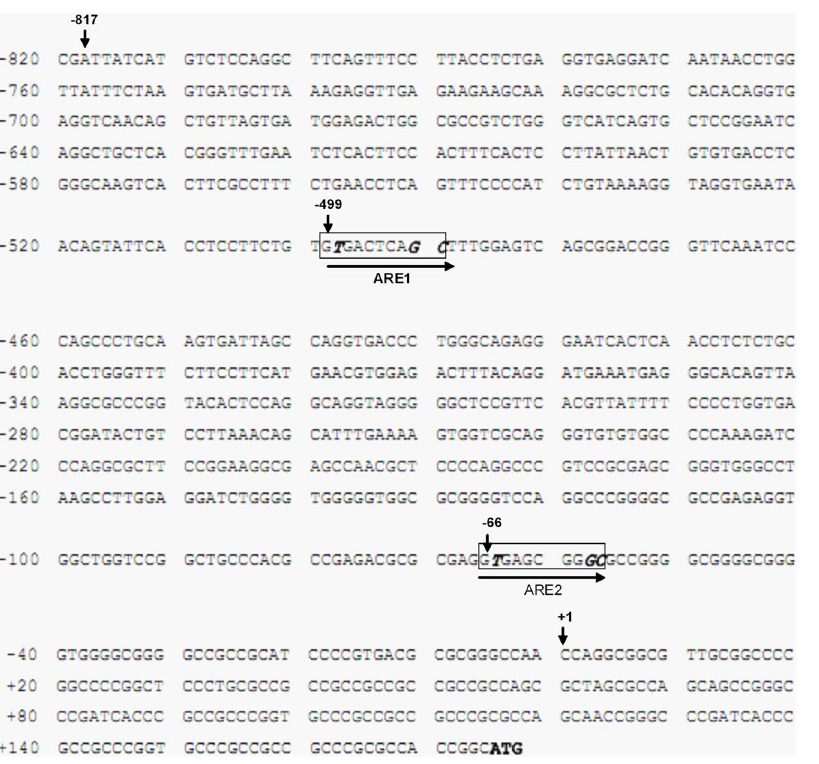
Figure 3. Nucleotide sequence of the 5 9 -flanking region of the hMrp1 gene containing two potential ARE sites. Nucleotides were numbered relative to the transcription start site ( + 1). The translation initiation codon (ATG) was in bold. Boxed region indicated ARE1 and ARE2 respectively. The nucleotides to be mutated in this study were in bold italic.